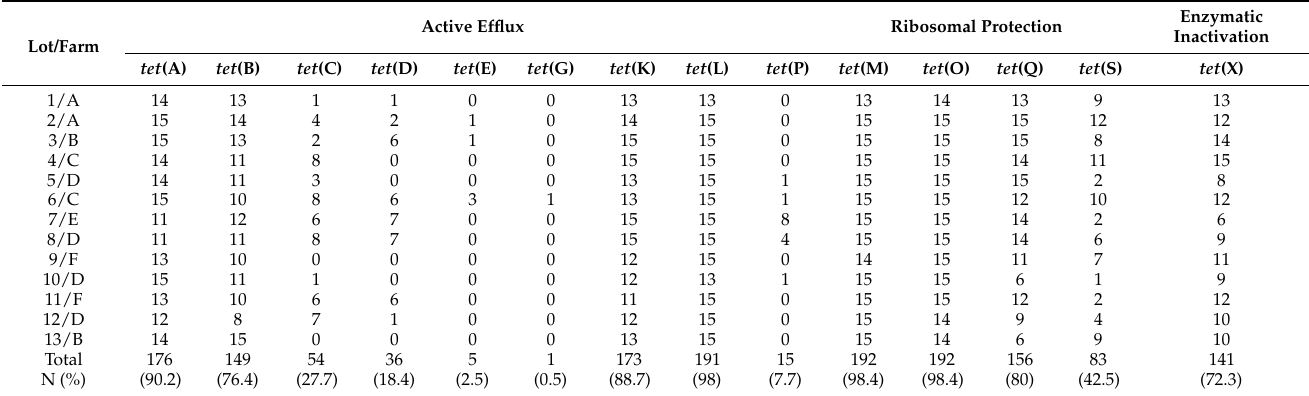
Table 2. Number of cloacal swabs PCR positive for the 14 tested tetracycline resistance ( tet ) genes encoding tetracyclines resistance (Each lot consisted of 15